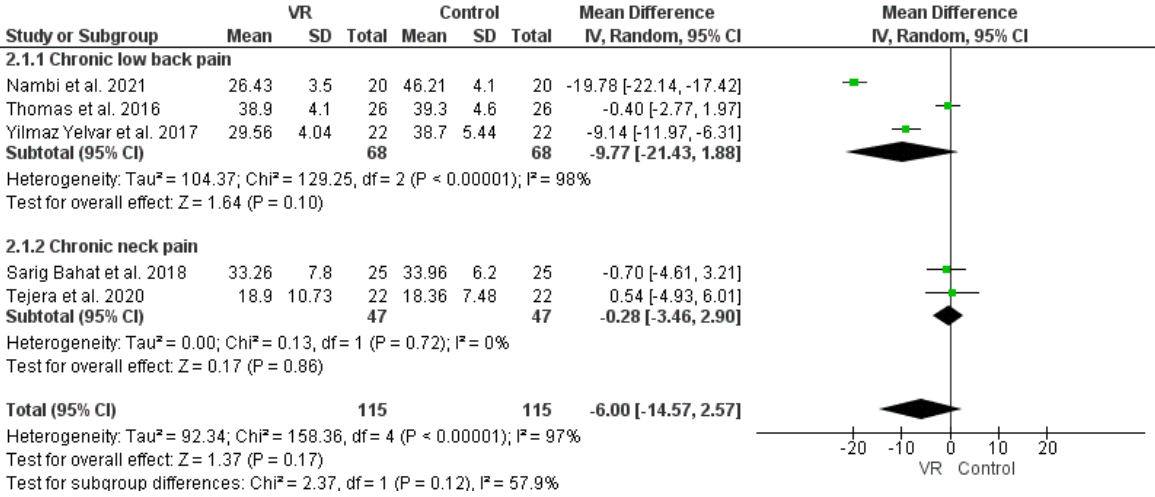
8 of 16 Figure 4. Effect of VR and other interventions on VAS improvement. Green squares represent mean difference for each study, while black rhombus represents the aggregated average of the mean differences. Figure 5. Effect of VR and control on PPI. Green squares represent mean difference for each study, while black rhombus represents the aggregated average of the mean differences. 3.2.2. Measure of Secondary Outcome